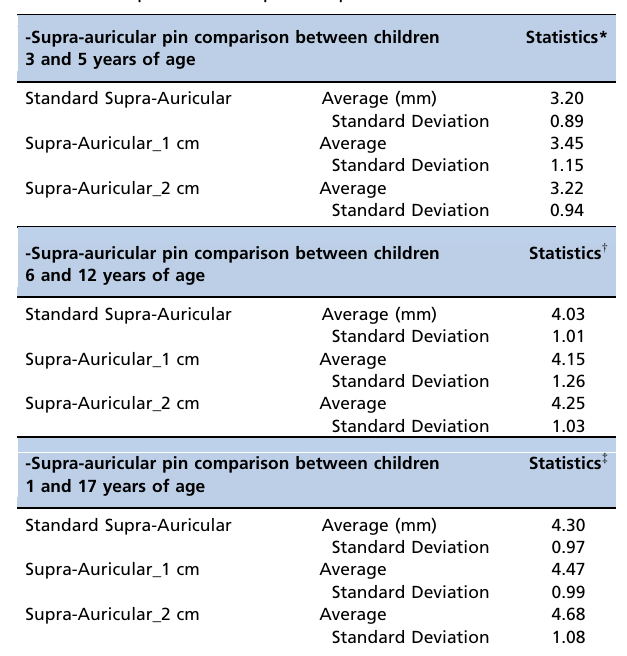
Table 1 - Supra-auricular pin